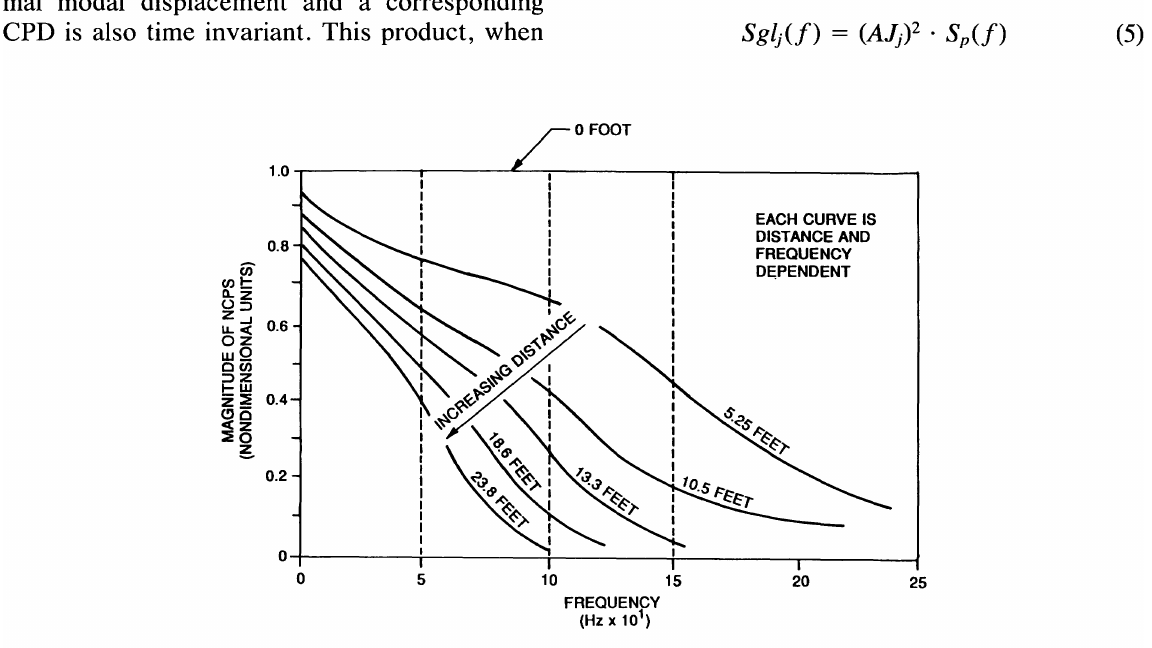
FIGURE 6 Launch-induced acoustic field model (horizontal